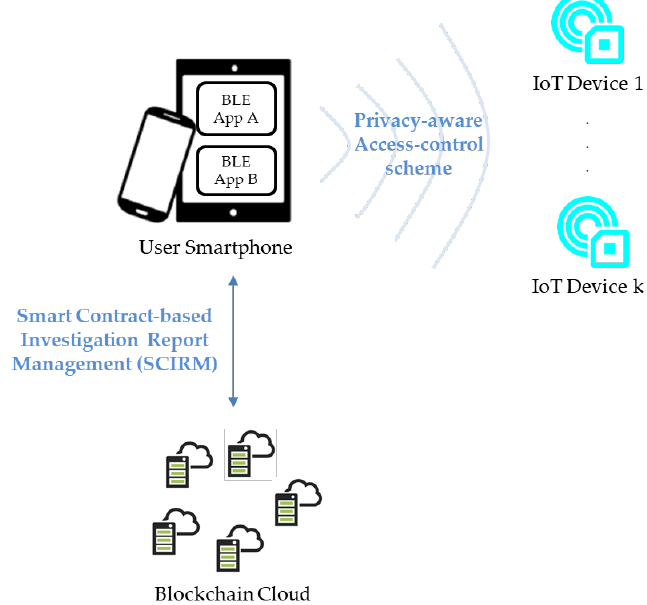
Figure 2. The proposed security paradigm for BLE-based applications associated with IoT devices.